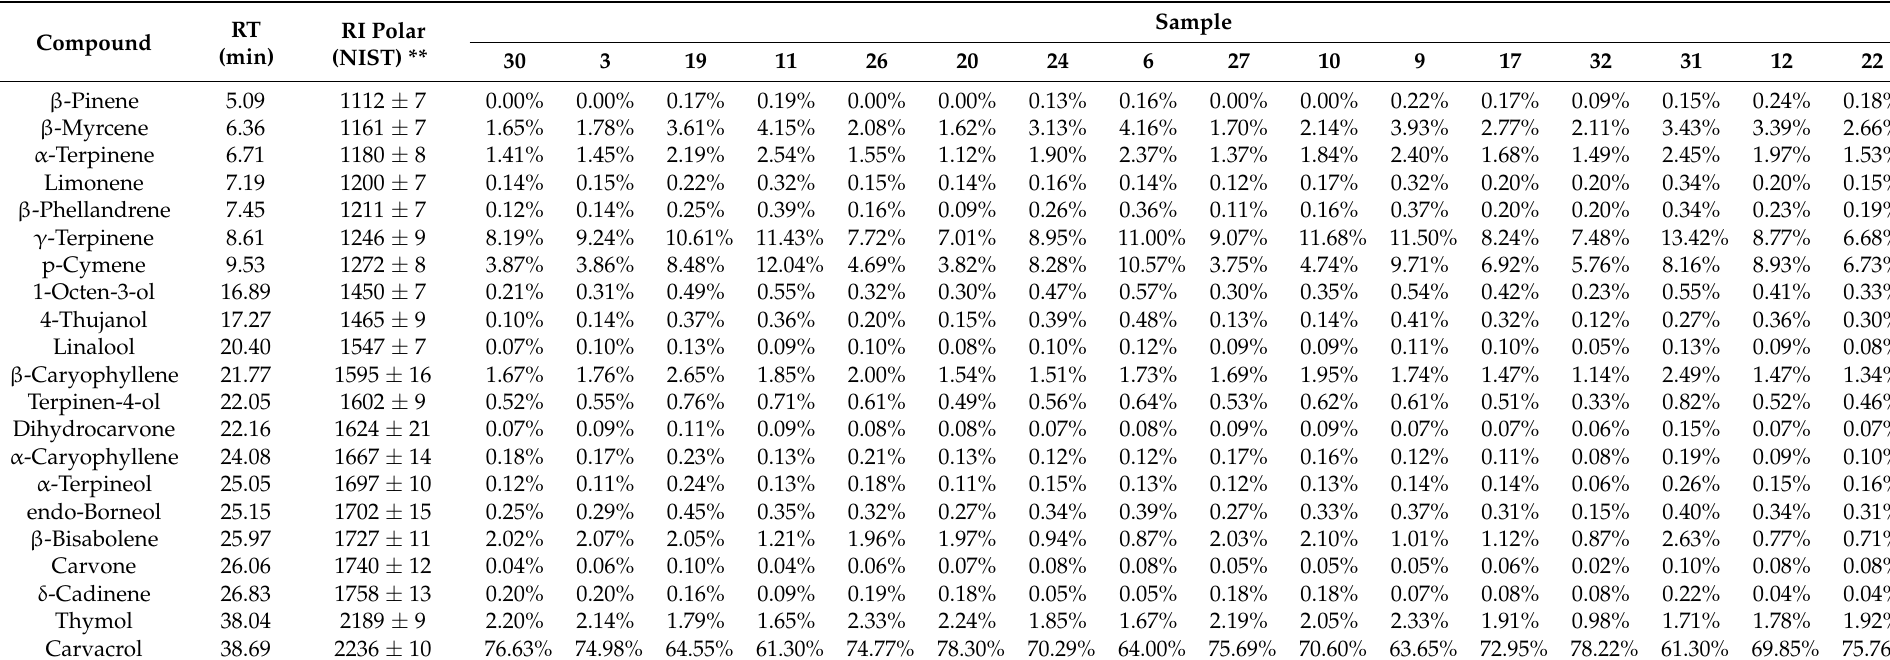
Table 2. Detected compounds by headspace GC-MS and their relative abundance * in the volatile fraction of the 32 oregano essential